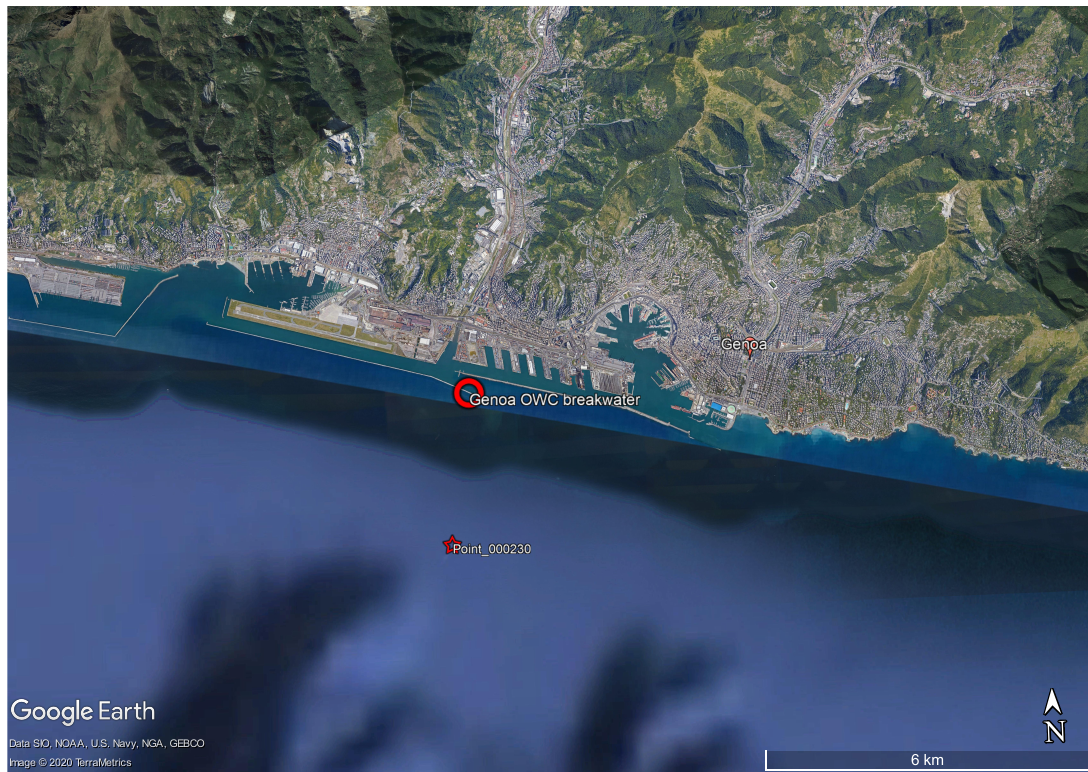
Figure 2. Close-up at area of interest, hindcast node 000230 and the node where local wave data were carried out are